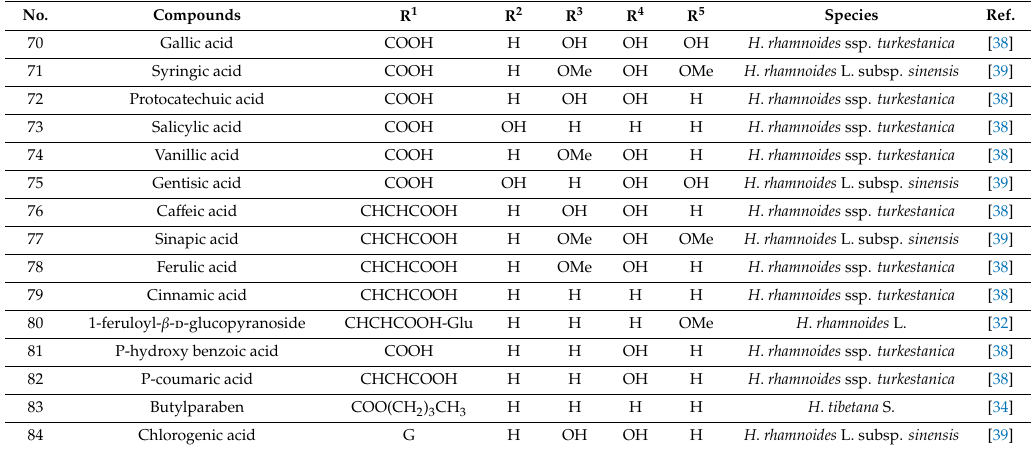
Figure 4. Chemical structures of phenolic acids from Hippophae species. Table 2. Phenolic acids from Hippophae species.